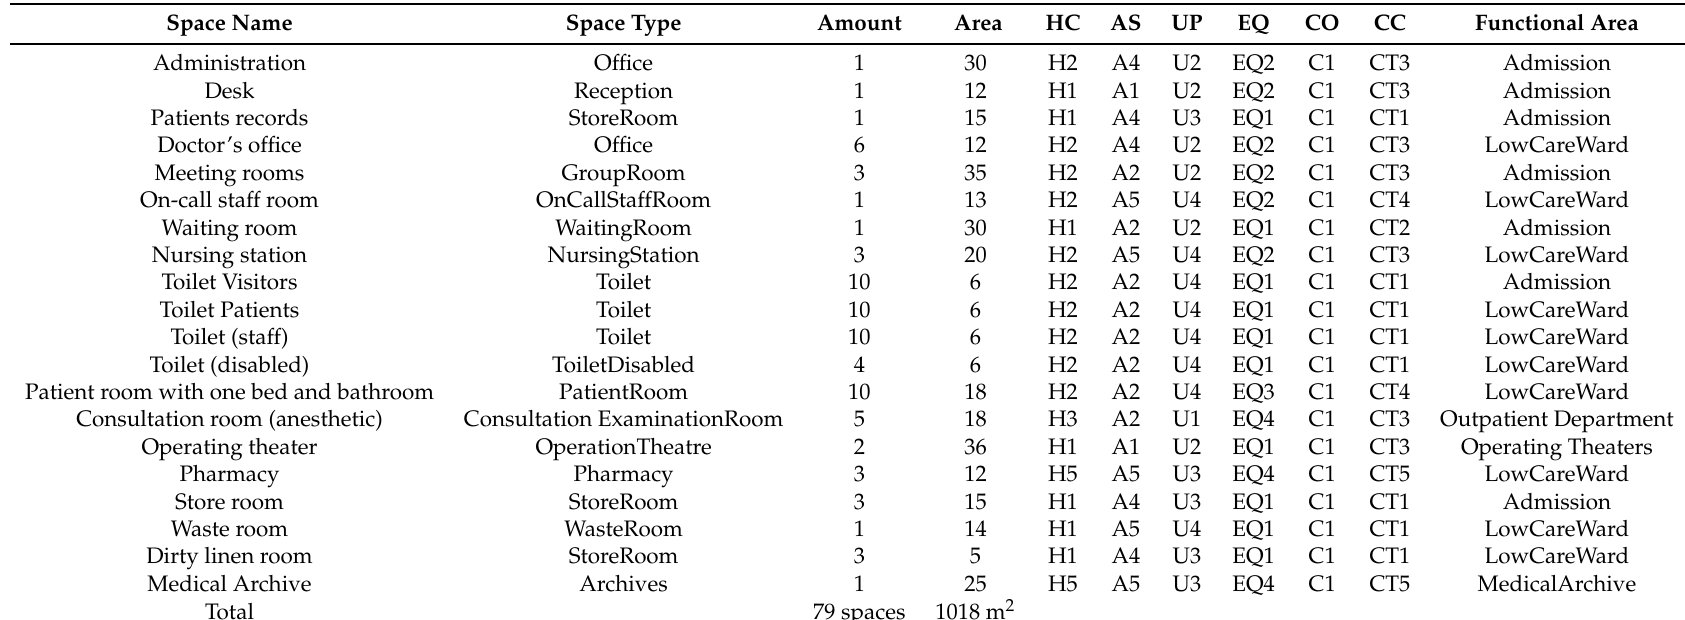
Table 3. Brief and assigned labels in our validation